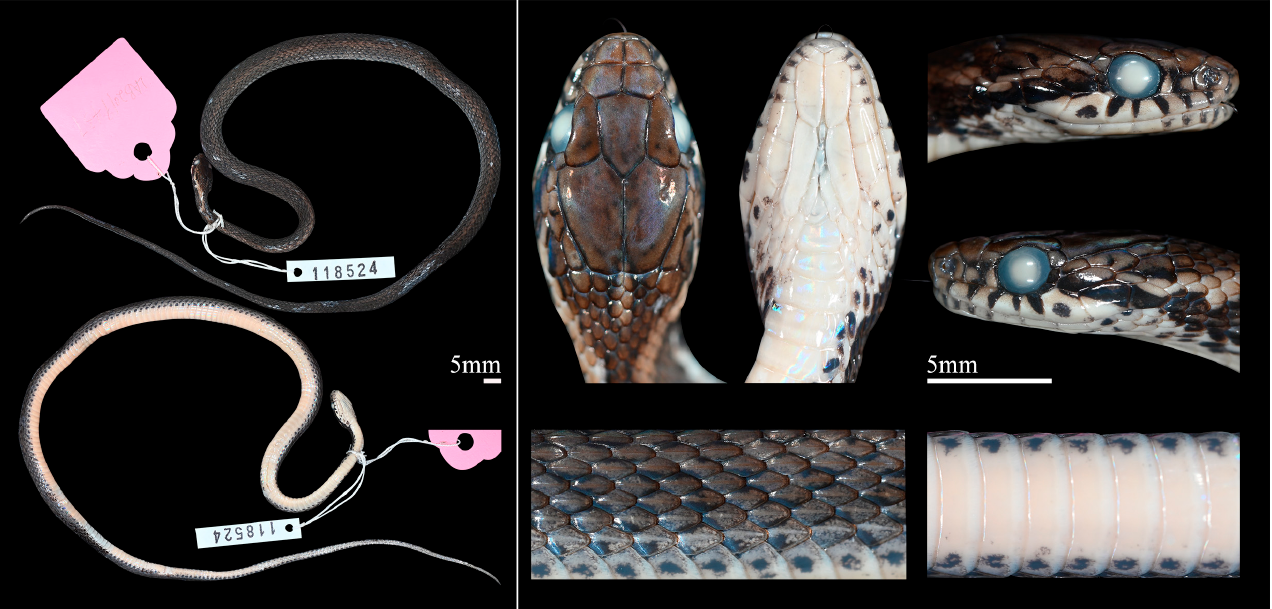
Figure 10. Preserved paratype of Herpetoreas tpser sp. nov. , CIB 118524, subadult, Mêdog County, Xizang Autonomous Region, China. Photographs by Jun-Jie Huang. Table 3. Morphological characters of Herpetoreas tpser sp. nov. specimens.